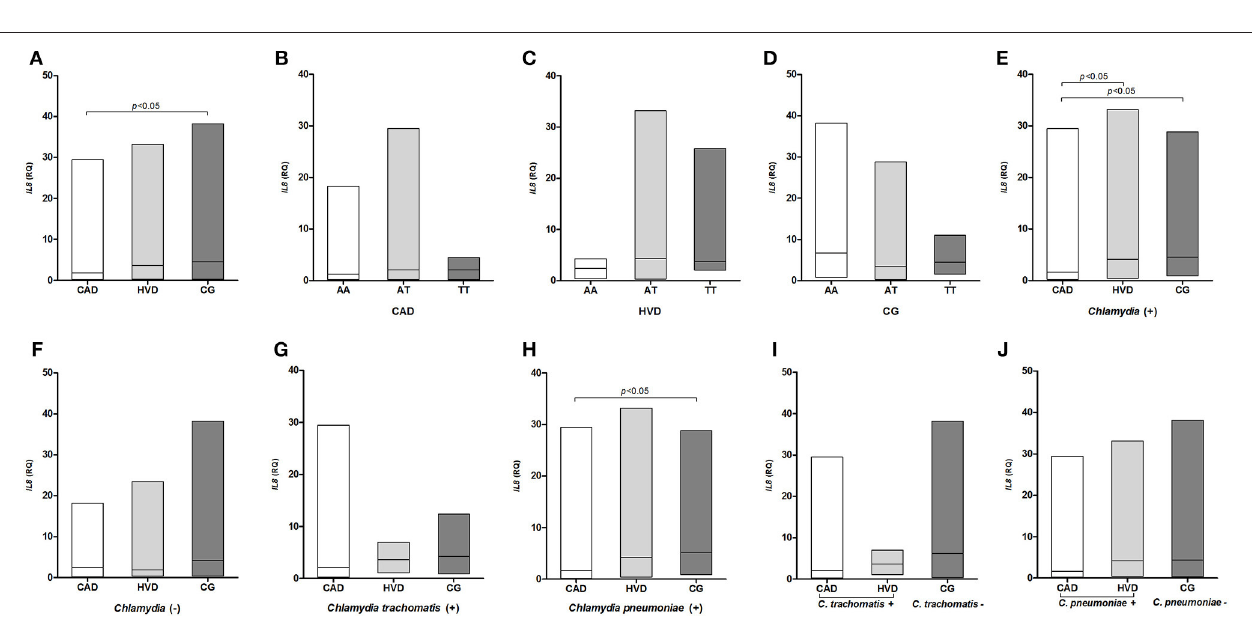
FIGURE 4 | Distribution of the IL-8 mRNA levels (A) among patients receiving surgical revascularization for coronary artery disease (CAD), patients undergoing valve replacement for heart valve disease (HVD) and control subjects (CG); (B–D) according to the different IL8 − 251T > A genotypes; (E) among groups serologically positive and (F) negative for Chlamydia; (G,I) among groups with and without previous exposure to C. trachomatis and (H,J) to C. pneumoniae .